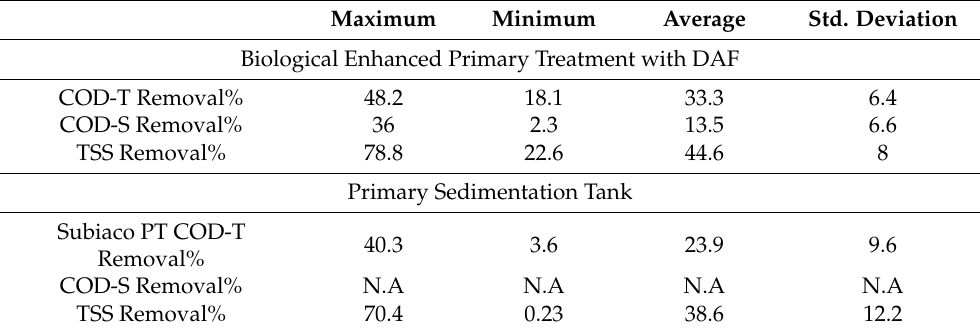
Table 1. Performance comparison of pilot-scale BEPT process and conventional primary treatment of wastewater.